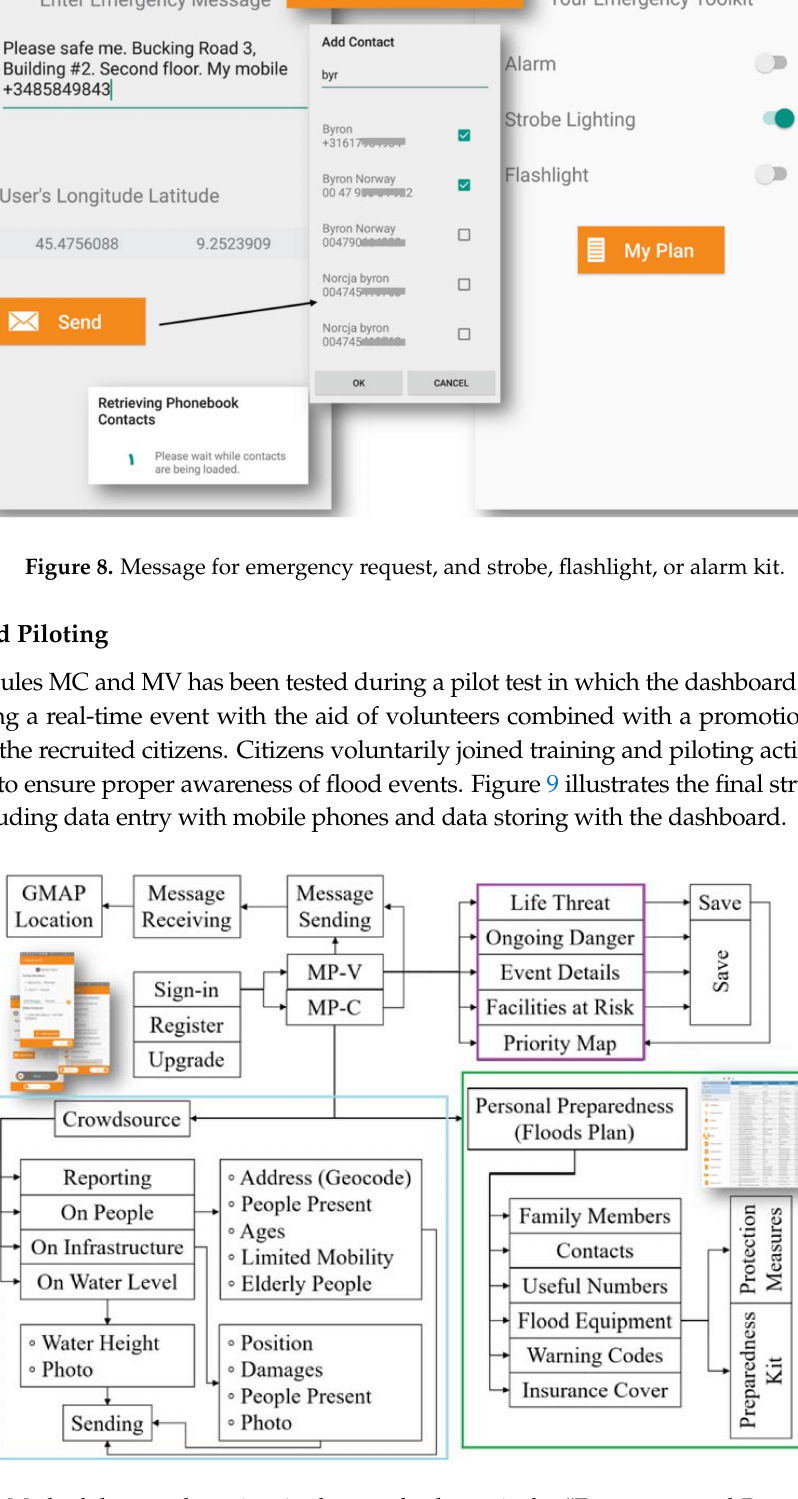
Figure 9. Methodology and service: in the purple cluster is the “Emergency and Rescue” section, in light blue is the “Crowdsourcing” section, and in green is the “Flood preparedness